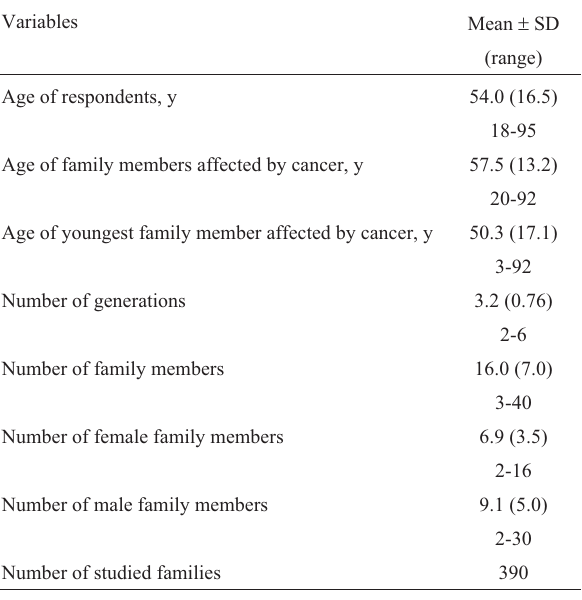
Table2 -Characterizationoffamilymembersaccordingtotheirage,num- ber, and gender of individuals in the pedigrees. Variables